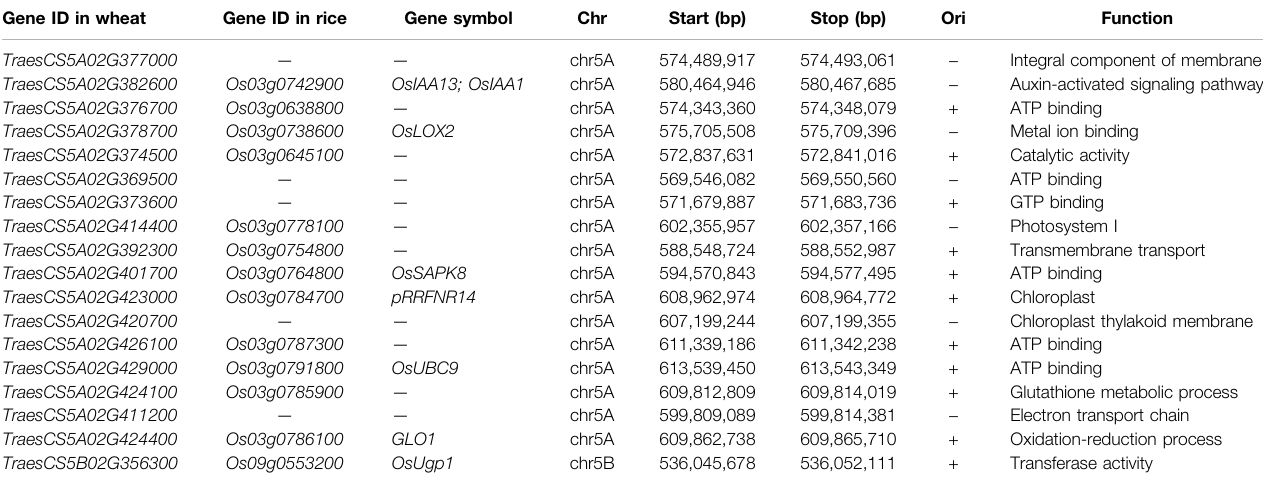
TABLE 4 | Functional annotation and enrichment of chlorophyll content QTLs on chromosomes 5A and 5B Gene ID in